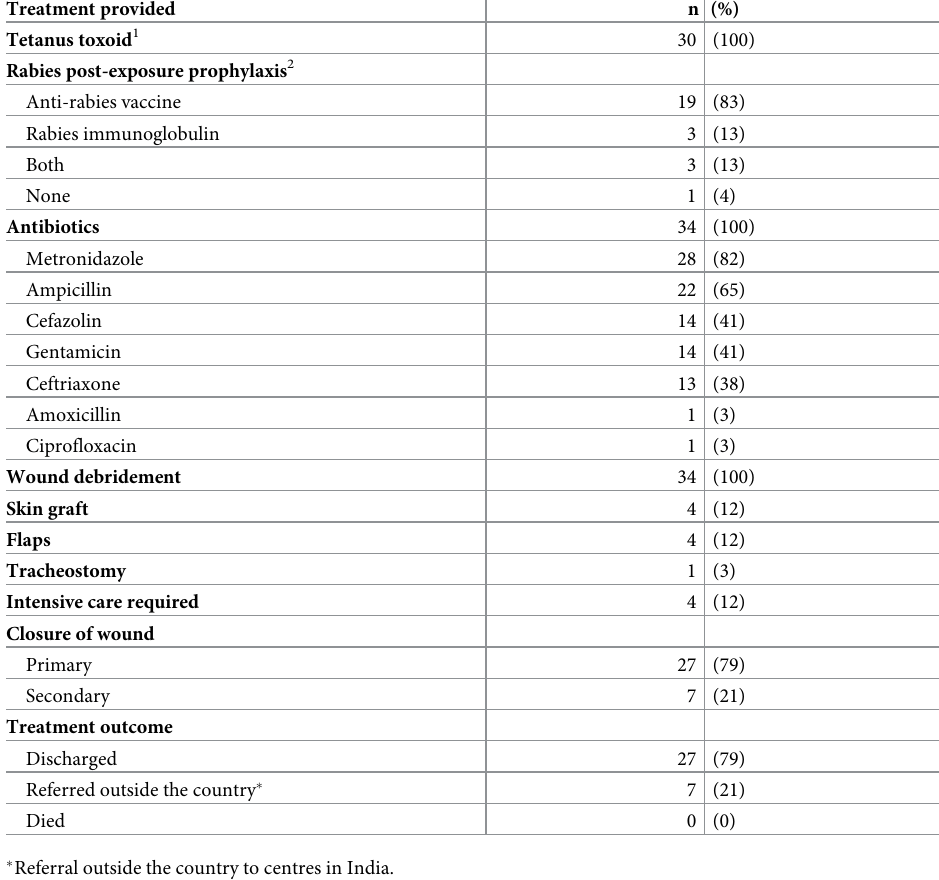
Table 4. Treatments offered to the victims of bear attacks at the Jigme Dorji Wangchuck National Referral Hospi- tal, Bhutan from 2015 to 2019. Treatment provided n (%) Tetanus toxoid